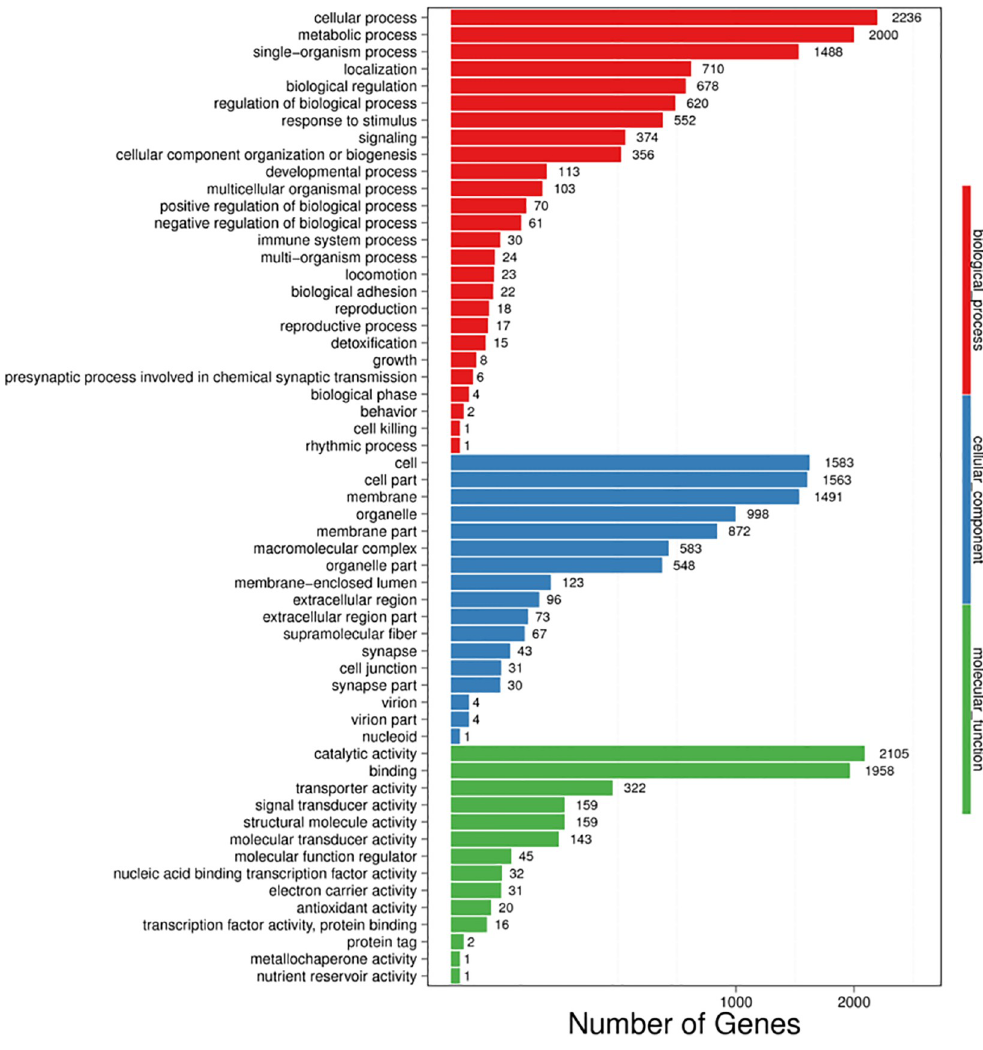
Fig 7. Gene Ontology annotation of the unigenes from P . viridis mantle